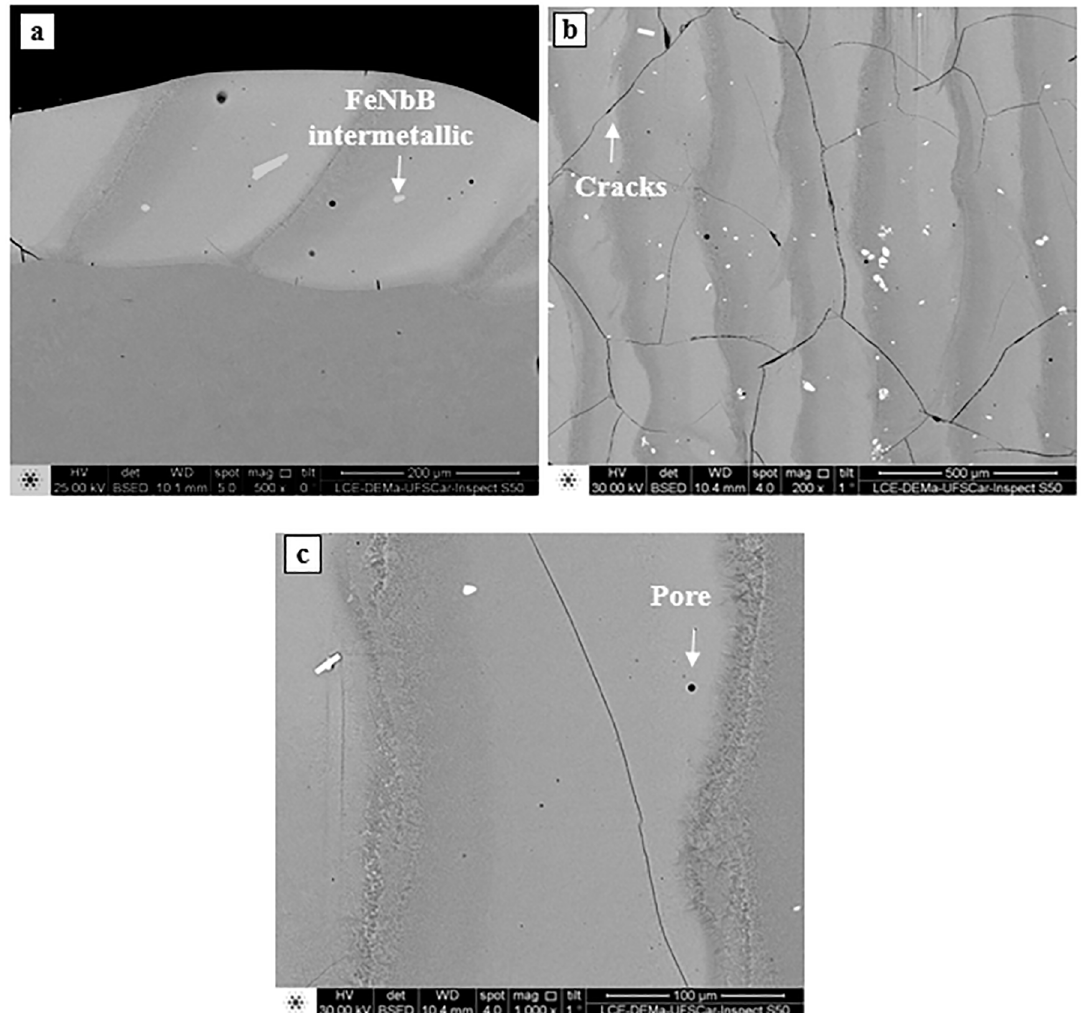
Figure 2. Typical SEM-BSE micrographs of the (a) coating cross-section, (b) coating surface and (c) magnification of (b), produced by LC process from Fe Cr Nb B (at%) alloy in the pre-placed spray formed powder at LASER power of 200 W and scanning speed of 10 60 8 8 24 mm/s, with different overlaps of 66%, 53% and